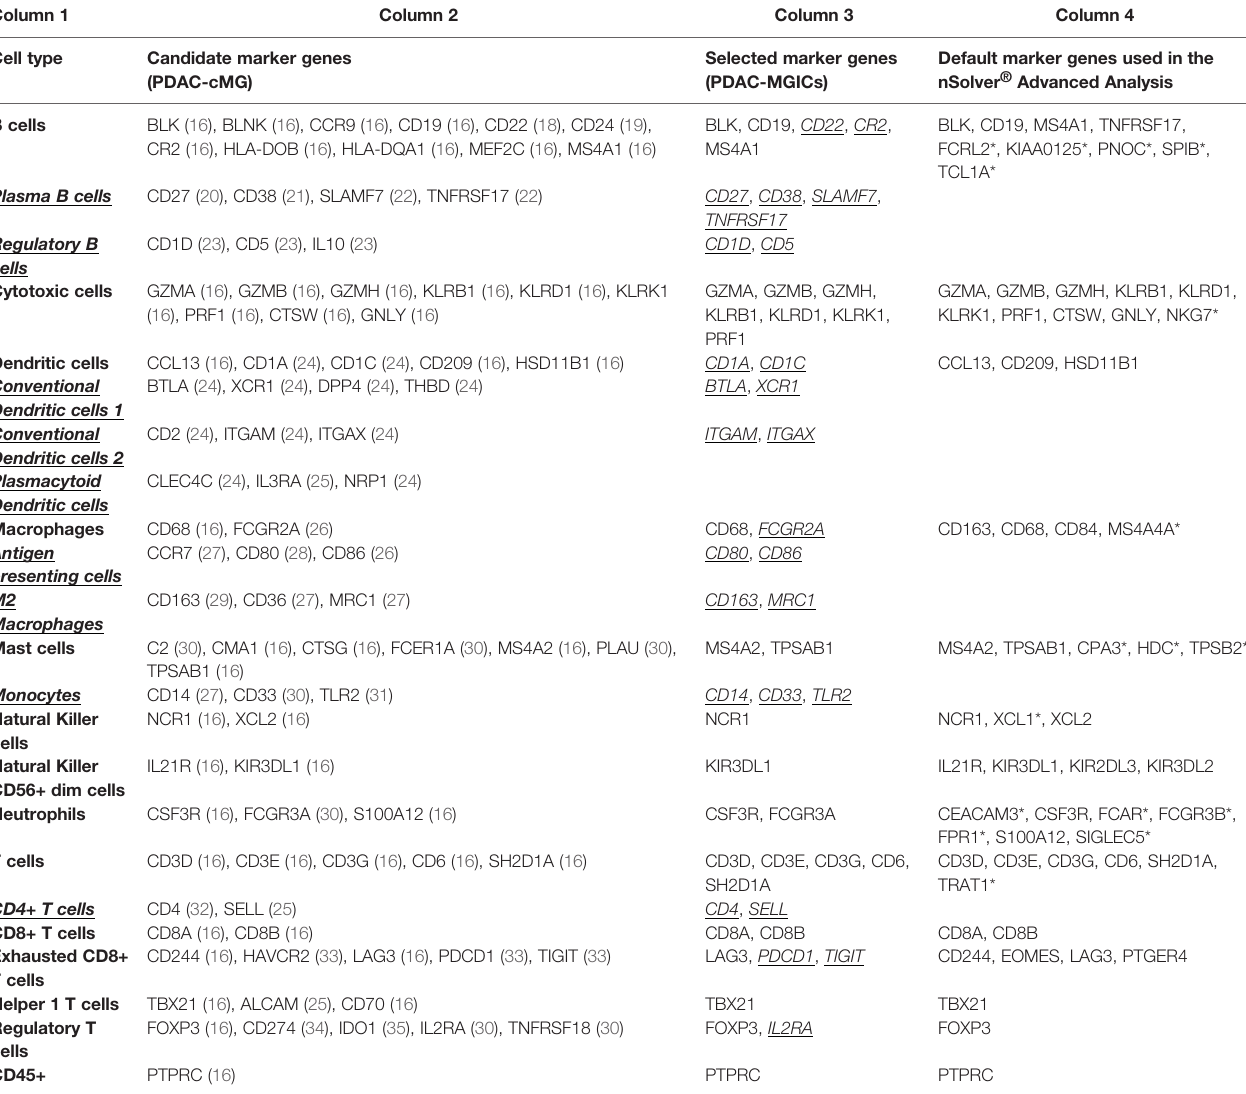
TABLE 1 | Summary of the candidate gene set and the selected marker genes used to identify immune cell types in PDAC tissue